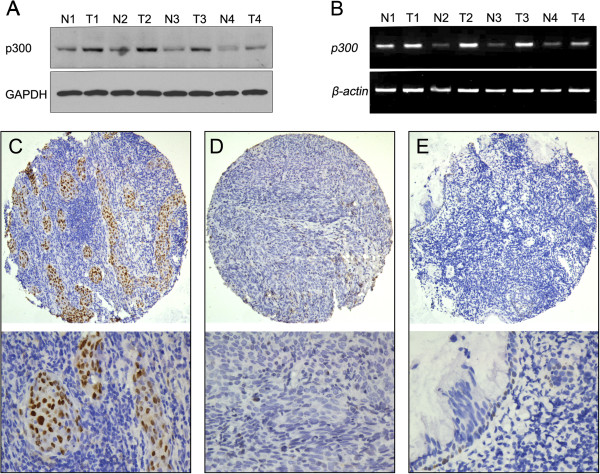
The mRNA and protein expression of p300 in NPCs and nonneoplastic mucosal tissues.A. Up-regulated expression of p300 mRNA was examined by RT-PCR in 4/4 NPC cases, when compared with n nonneoplastic mucosal tissues. B. Up-regulated expression of p300 protein was detected by Western blotting in 4/4 HCC cases, when compared with nonneoplastic mucosal tissues. C. High expression of p300 was observed in a NPC, in which more than 90% tumor cells revealed positive immunostaining of p300 in nuclei (upper panel, ×100). D. A NPC case demonstrated low expression of p300, in which less than 5% of tumor cells showed immunoreactivity of p300 protein in nuclei (upper panel, ×100). E. The nonneoplastic mucosal tissue showed nearly negative expression of p300 protein (upper panel, ×100). The lower panels indicated the higher magnification (×400) from the area of the box in C., D., and E., respectively.